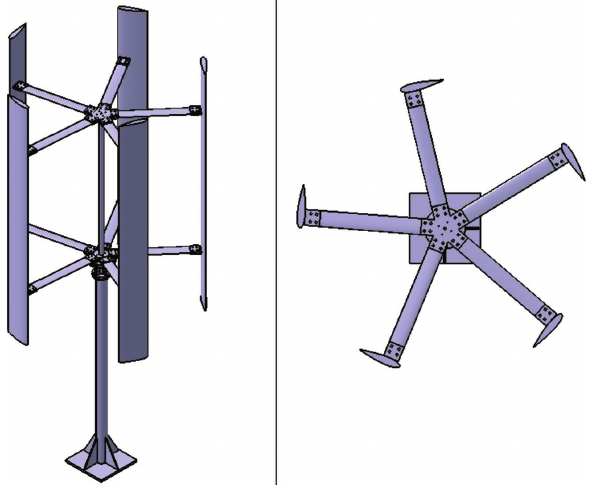
Figure 5 Designed 500 W VAWT configuration.